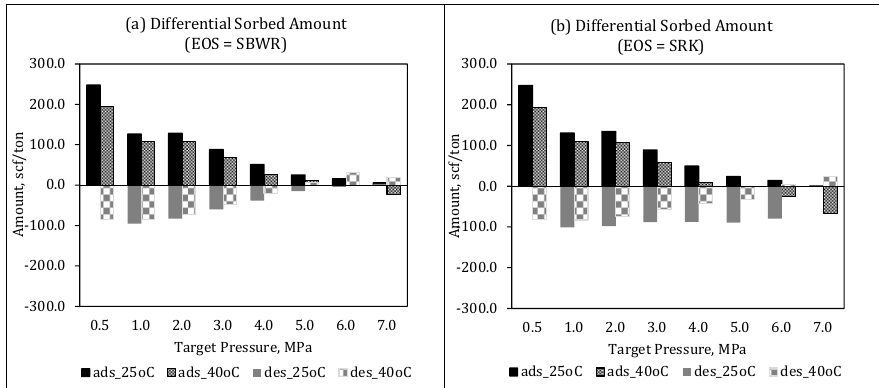
Figure 7. Comparing differential ad/desorbed amounts Vs. EOS.